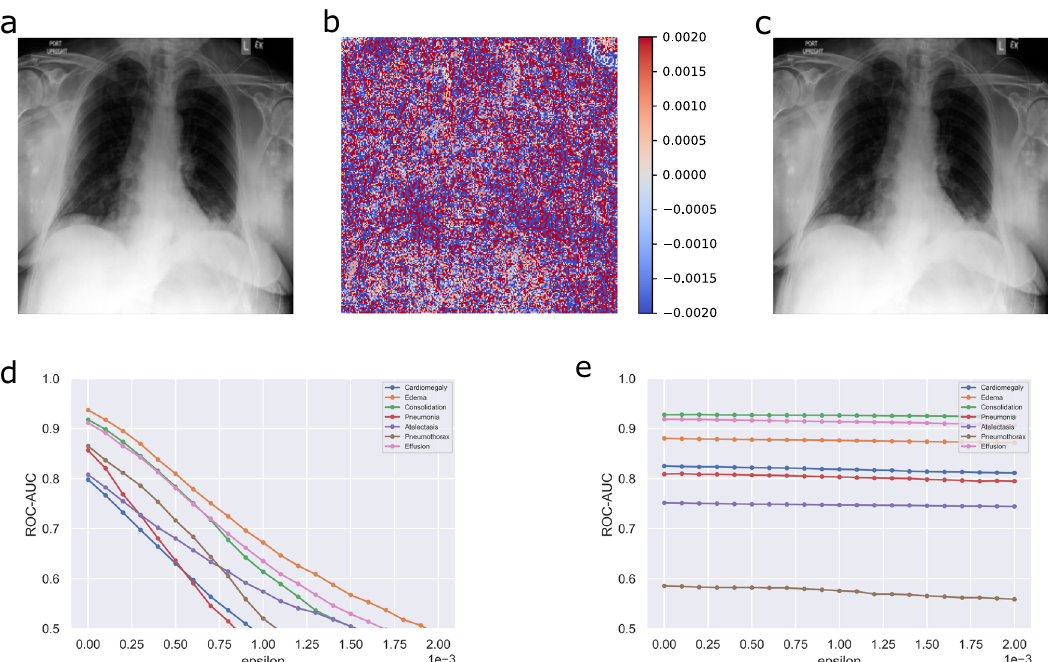
Fig. 1 Adversarially trained models are robust against adversarial attacks. Adversarial perturbations with increasing strength ( ϵ ) were generated via an projected gradient descend (PGD) attack. To demonstrate the impact of adversarial attacks on state-of-the-art classi fi ers, we trained a ResNet-50 models with a large chest X-ray dataset (CheXpert) containing nearly 200,000 X-rays. a Original unmanipulated chest radiograph. b Adversarial noise with ϵ = 0.002. c Manipulated chest radiograph (original radiograph + noise), i.e. adversarial example. d The standard model was easily misled by small adversarial perturbations ( b ) that are not perceptible to the human eye ( c ) and accuracy in classifying the disease dropped drastically when allowing more pronounced perturbations. e Only a limited amount of performance degradation was observed when applying adversarial attacks on the model trained adversarially ( ϵ during training was set to